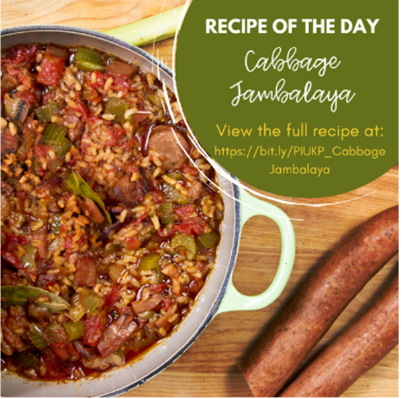
Figure 2. Example of a post for O+I Facebook group participants.